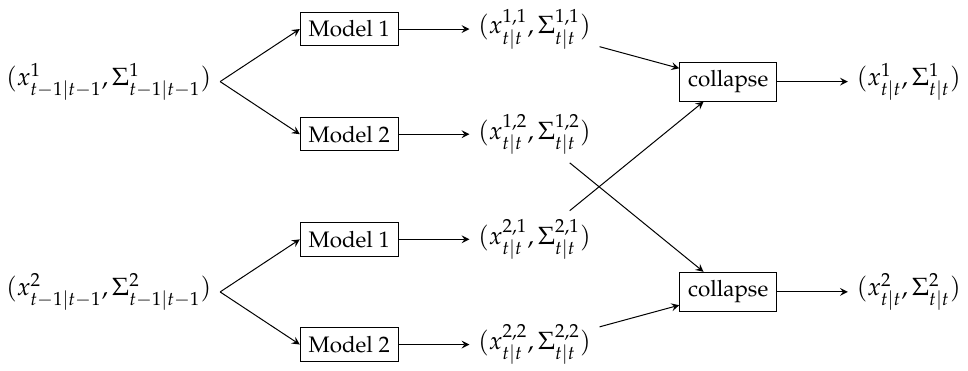
Figure 3. Second order Generalized Pseudo Bayesian collapse strategy using two models. Having the initial belief state estimated by a mixture of two Gaussians at t − 1, the posterior belief at t is represented by a mixture of four Gaussians (taking into account model switching probability). Finally, four Gaussians are collapsed back to two following moment